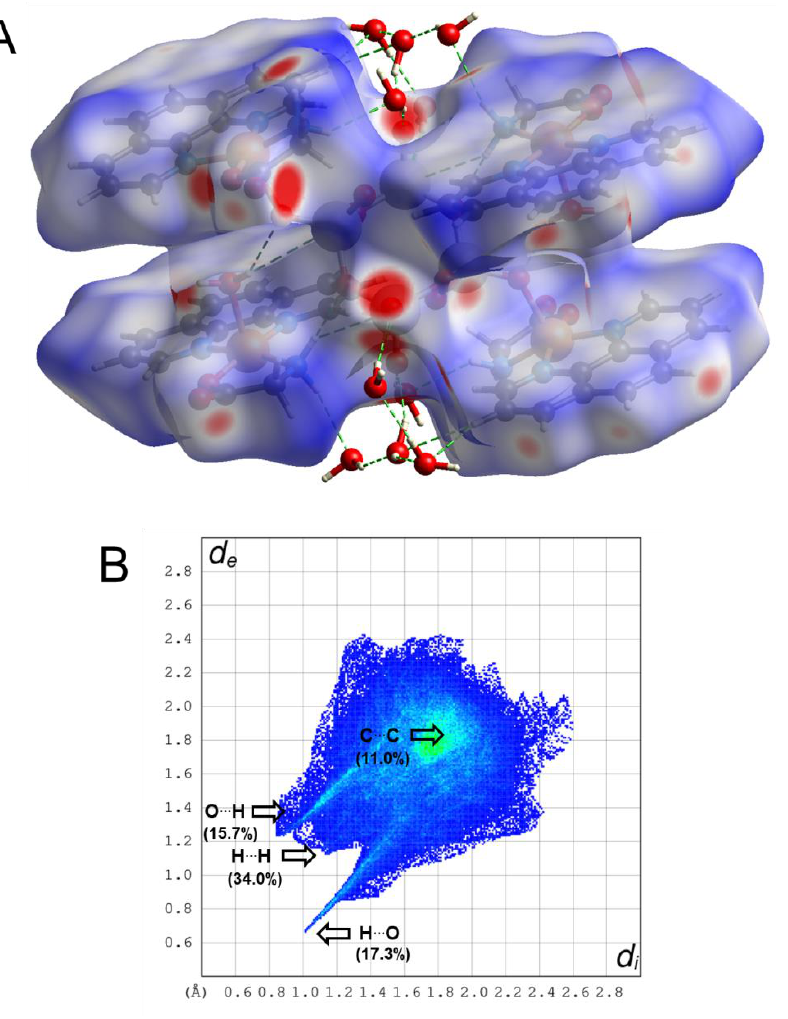
Figure 9. ( A ) Hirshfeld surface mapped with d norm parameter. ( B ) Fingerprint plot of noncovalent interactions .